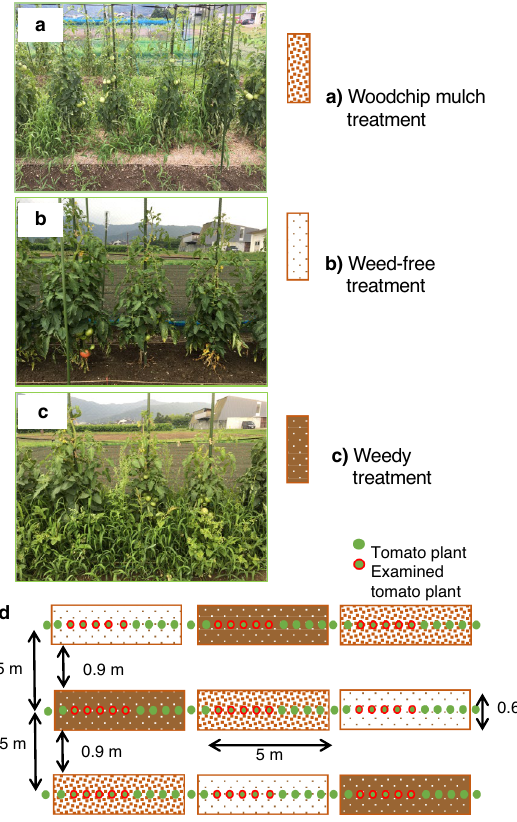
Figure 1. Photos of the examined cultivation treatments and the planting design for tomato plants. ( a ) The woodchip mulch treatment, ( b ) the weed-free (i.e., weeded) treatment, ( c ) the weedy (i.e., unweeded) treatment and ( d ) the cultivation design. Each treatment had three replicates (separated ridges). Tomato seedlings were transplanted at a 0.5 m interspace on 26 April 2016 and on 9 May 2017. The photos were taken by K. Fukuda (the second author).